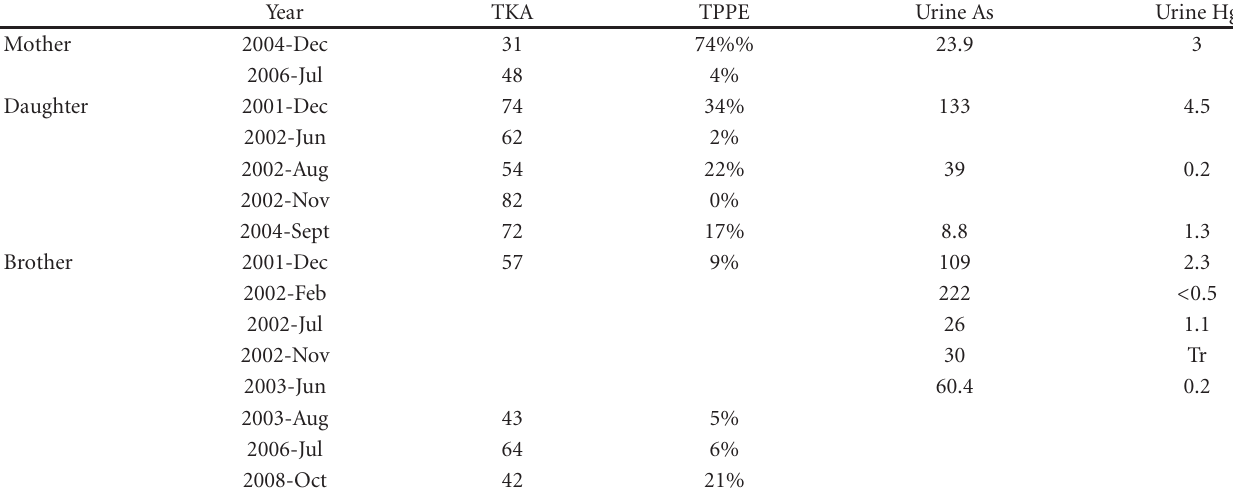
Table 1: Changes in transketolase activity (TKA), thiamine pyrophosphate e ff ect (TPPE), and urinary heavy metal for the three family members. Normal TKA 42–86mU/L/min. Acceptable range for TPPE 0–18%. Acceptable range for urinary arsenic 0–45 mg/G. Cr, for mercury, only